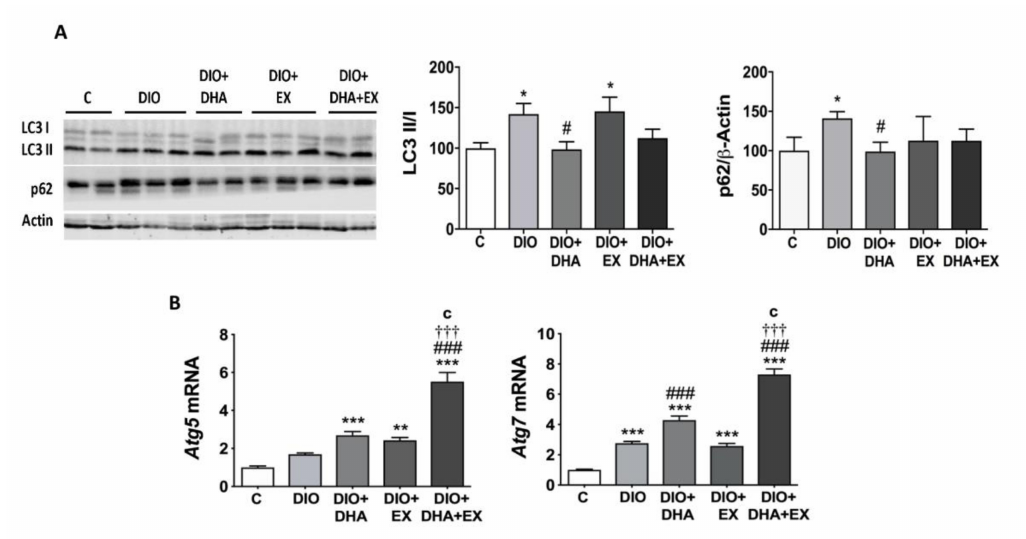
Figure 4. Long-term DHA supplementation and/or aerobic exercise training regulates the expression of key autophagy- related proteins/genes in the liver of 18-month-old DIO mice. ( A ) Representative Western blot (left panel) and densitometry analysis (right panels) of LC3 I and II and p62. Band densities of p62 were normalized to β -actin. ( B ) mRNA expression levels of hepatic Atg5 and Atg7 . Data are expressed as mean ± SEM. n = 6–10. * p < 0.05, ** p < 0.01, *** p < 0.001 vs. C group. # p < 0.05, ### p < 0.001 vs. DIO group. ††† p < 0.001 for DIO + DHA vs. DIO + DHA + EX group. c p < 0.001 for DIO + EX vs. DIO + DHA + EX